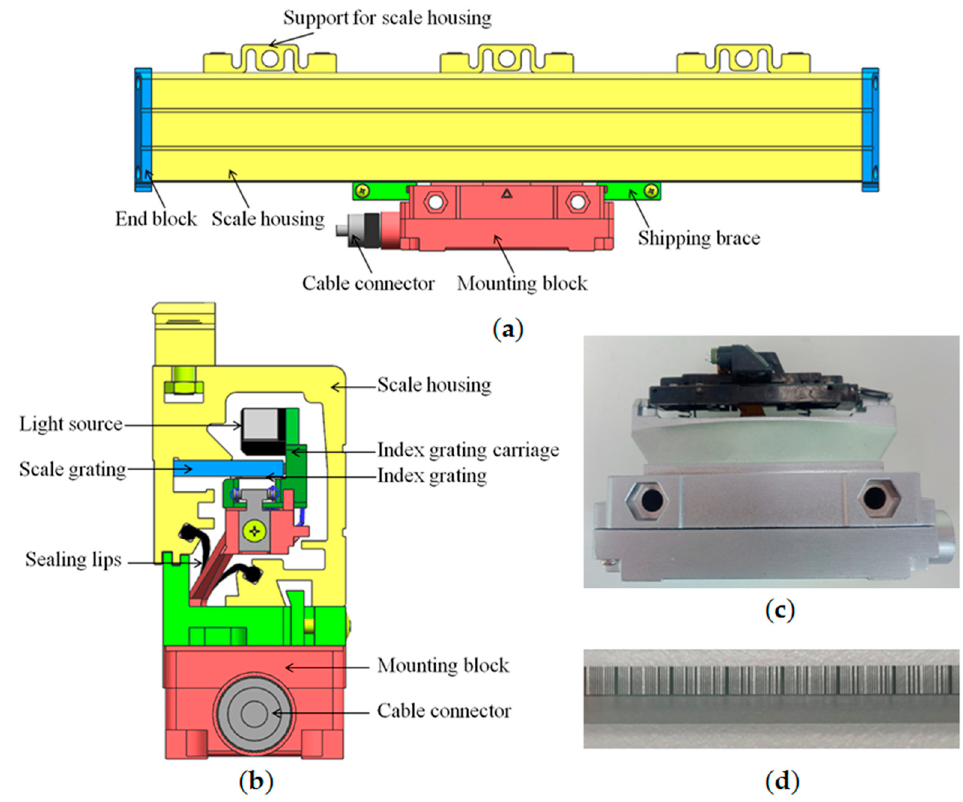
Figure 8. Structure of absolute linear encoder. ( a ) External structure; ( b ) internal structure; ( c ) scanning carriage; ( d ) part of scale grating.